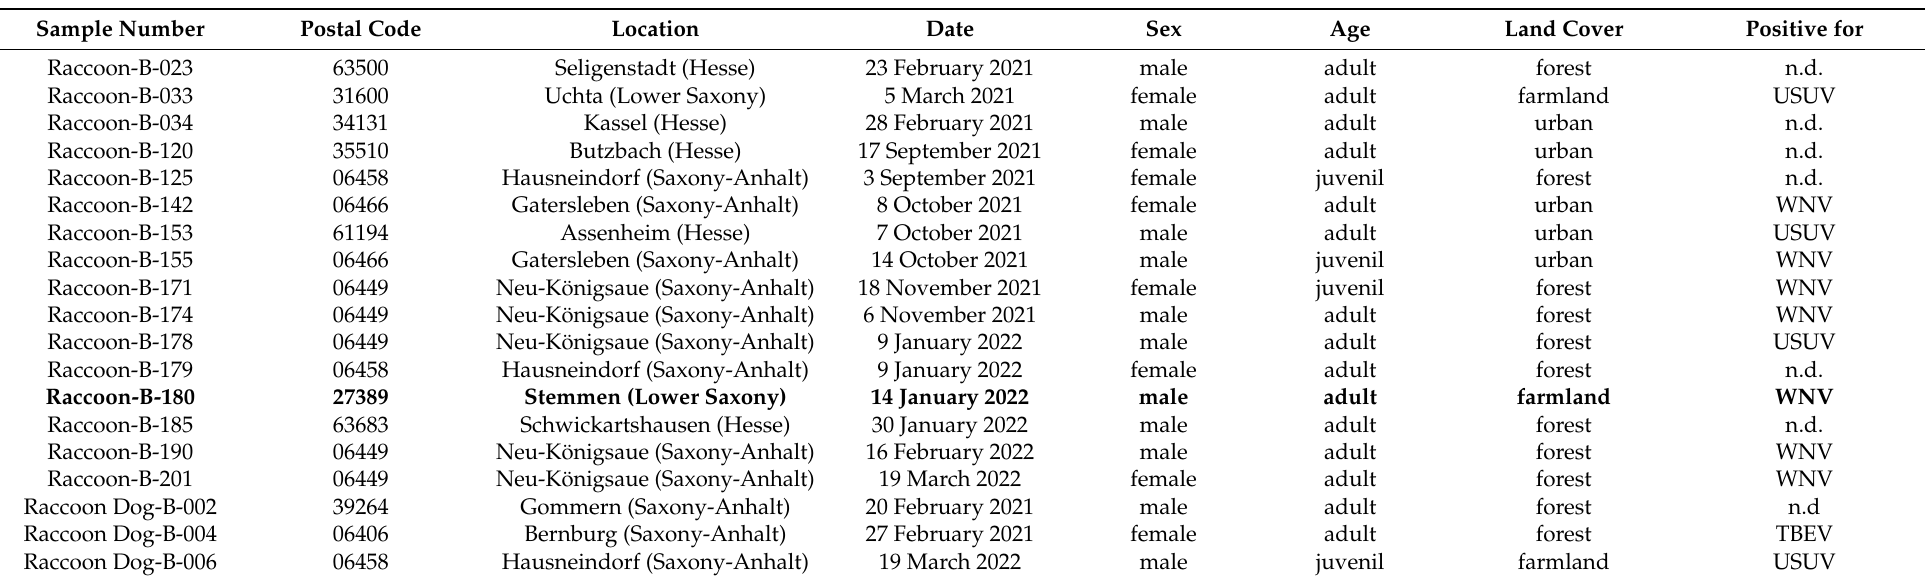
Table 2. Origin of animals found positive in neutralization assays. One animal tested positive for WNV originated from Lower Saxony (bold), all others from Saxony-Anhalt. Another raccoon from Lower Saxony is positive for antibodies against USUV, while WNV antibodies were not detected in this animal. WNV positive raccoon from Lower Saxony is shown in bold. n.d.: No differentiation by neutralization assay